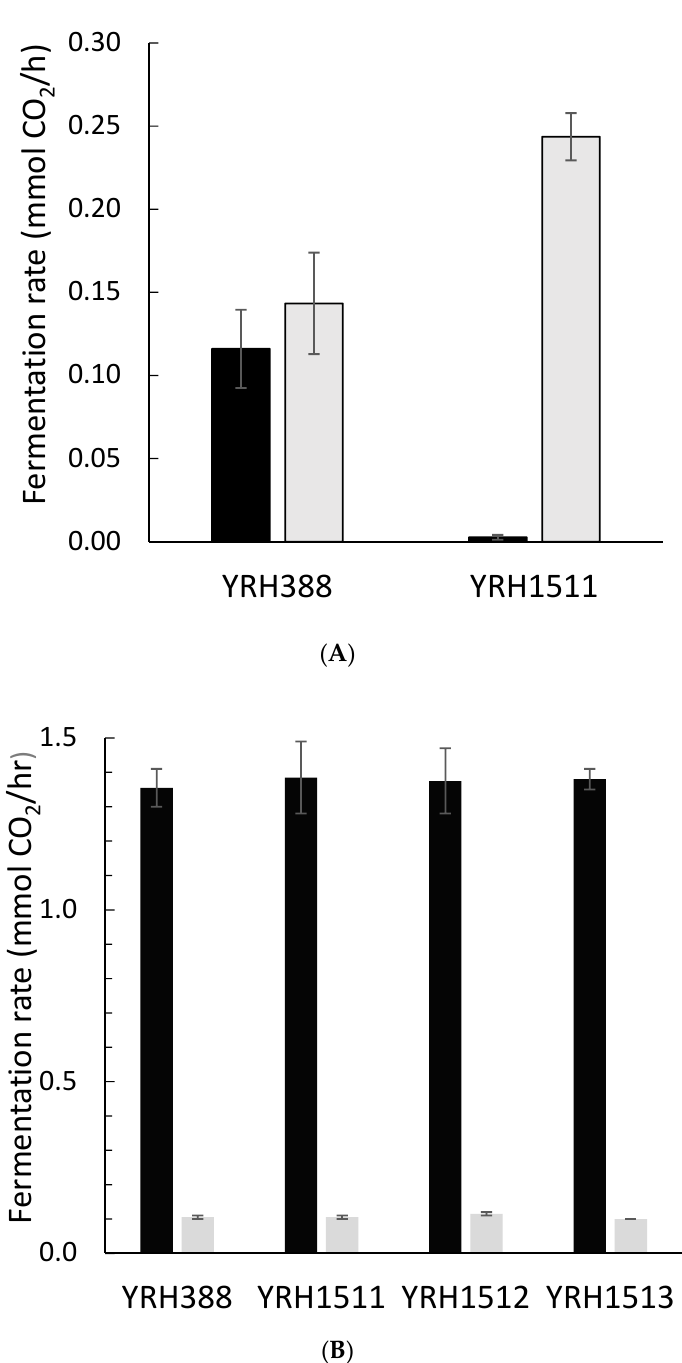
Figure 3. ( A ) . Fermentation of corn stover dilute-acid hydrolysate by YRH388 and ZWF1 mutant YRH1511. Bars show rate of accumulation of CO 2 in unabated (black) or bioabated (gray) hydrolysates. Values are the average of three experiments each carried out with two or three replicates of bioabated hydrolysate and one unabated control. Plots are shown with error bars representing the standard error. ( B ). Fermentation of YP medium containing 1% each glucose and xylose. Bars show the maximum rate of accumulation of CO 2 during growth on glucose (black) and xylose